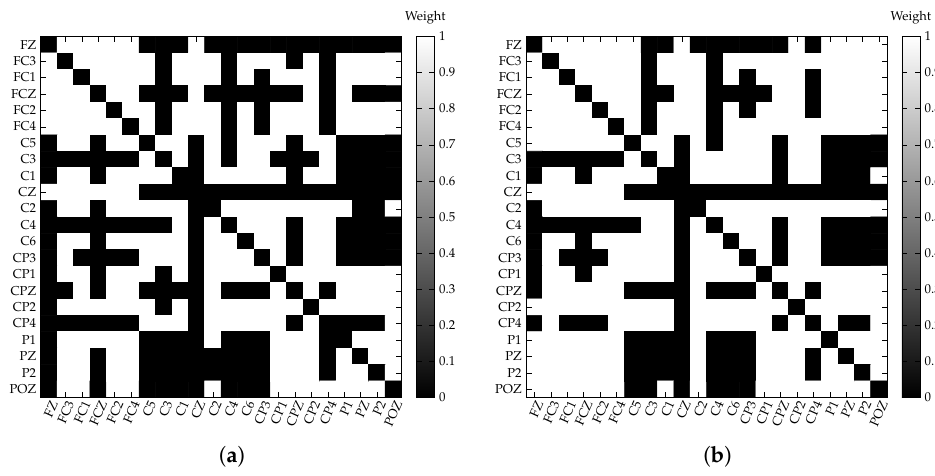
Figure 6. Example of the binarized adjacency matrix from Figure 3; ( a ) fixed threshold (0.9809) and ( b ) Otsu’s threshold (0.9750) for the β band (13–30 Hz) for the IM right-hand. ( a ) Example of the binarized adjacency matrix by a fixed threshold (0.9747), in the β band (13–30 Hz) for the IM of the left-hand. ( b ) Example of the binarized adjacency matrix by the Otsu’s threshold (0.9698), in the β band (13–30 Hz) for the IM of the